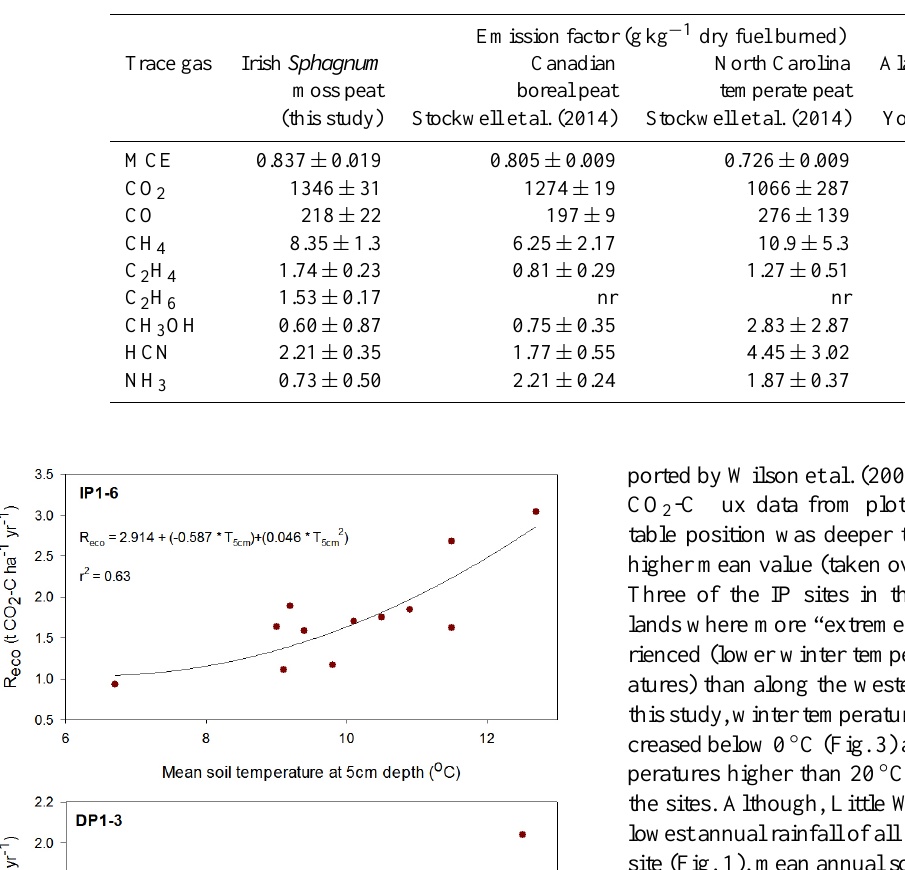
Table 3. Mean modified combustion efficiency (MCE) and emission factors (gkg − 1 dry fuel burned) reported by this study and those for the same trace gases reported by previous studies of temperate or boreal peat (Yokelson et al. 1997; Stockwell et al. 2014). The mean and standard deviation of the emission factor is calculated from individual sample burns; nr: not reported.